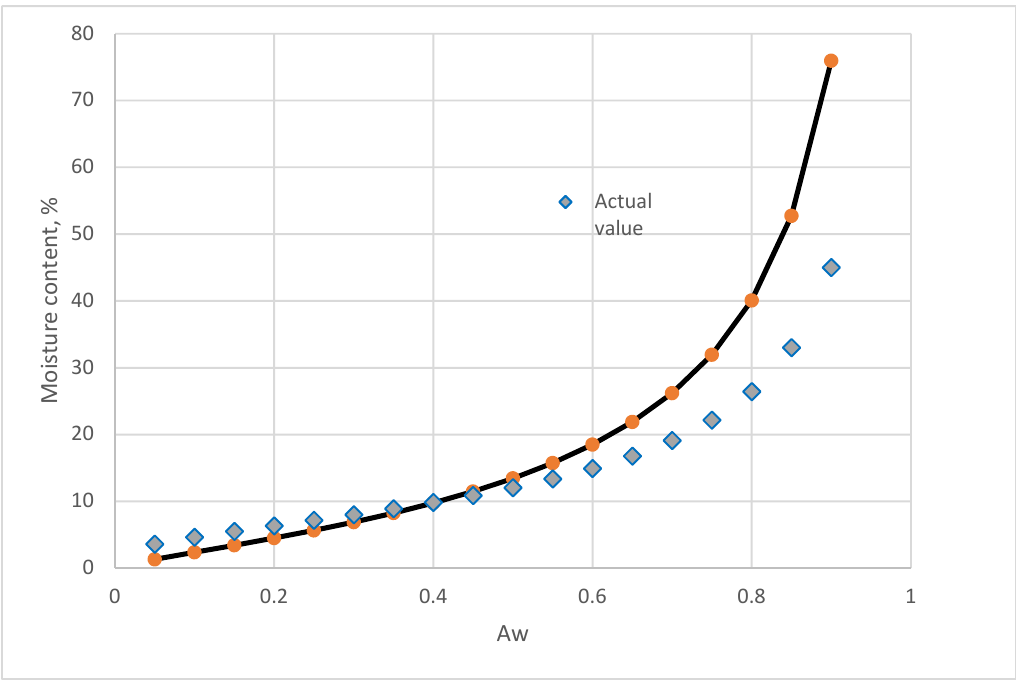
Figure 7. Comparing of the predictive values from the component model and the actual isotherm moisture of raw bamboo.